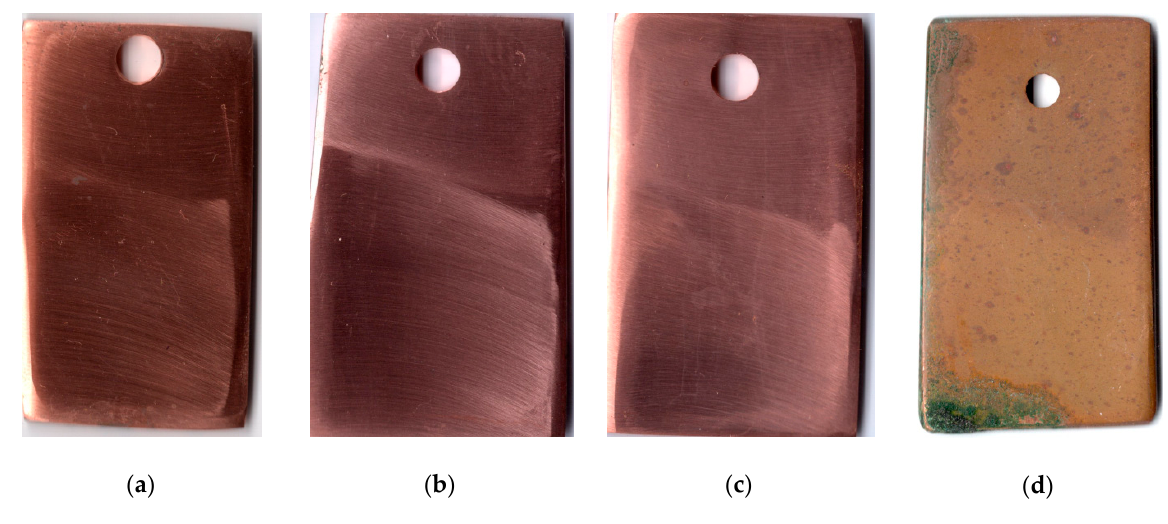
Figure 3. Copper samples after weathering tests for 25 months: chamber treatment with CIN vapors ( a – c ); without chamber treatment ( d ).